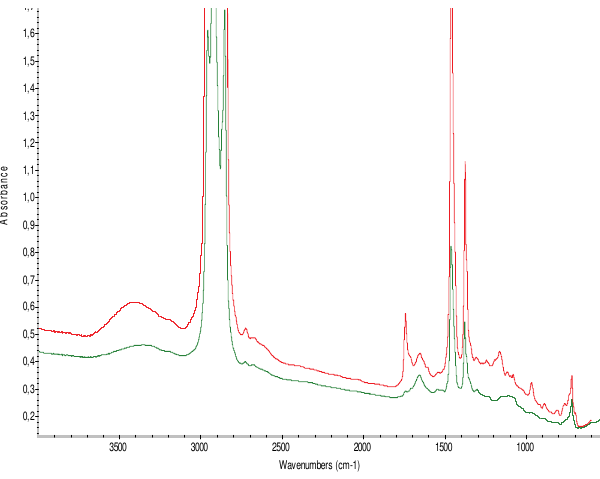
Fig. 9. Infrared spectrum of the soluble sediment from the injector open- ings (green) and nozzle levers (red) The band in the range of about 1655 cm –1 in the diag- nostic area of 2000–1600 cm –1 is also intensive, which indicates the presence of oxidation processes of organic compounds to carbonyl and carboxylic structures. The effects of these compounds on nitrogen oxides are related to Fig. 8. XRF spectrum for sediments from the injector openings and nozzle the presence of hydrated carboxylic acid salts. These sub- levers stances may also be derived from the oxidation and